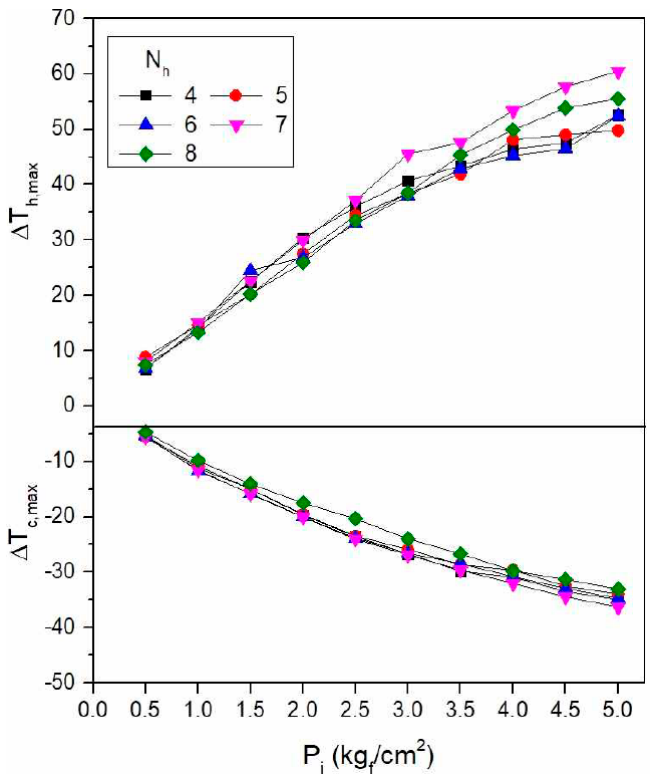
∆ T c, max according to the number of nozzle h, max and